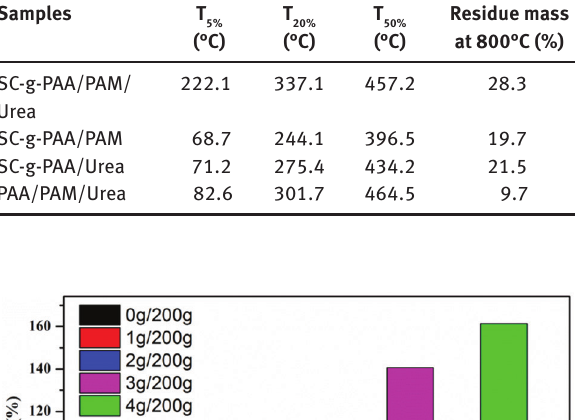
Table 3: Summary of thermal properties of SC-g-PAA/PAM/Urea, SC-g-PAA/PAM, SC-g-PAA /Urea and PAA/PAM/Urea. Samples